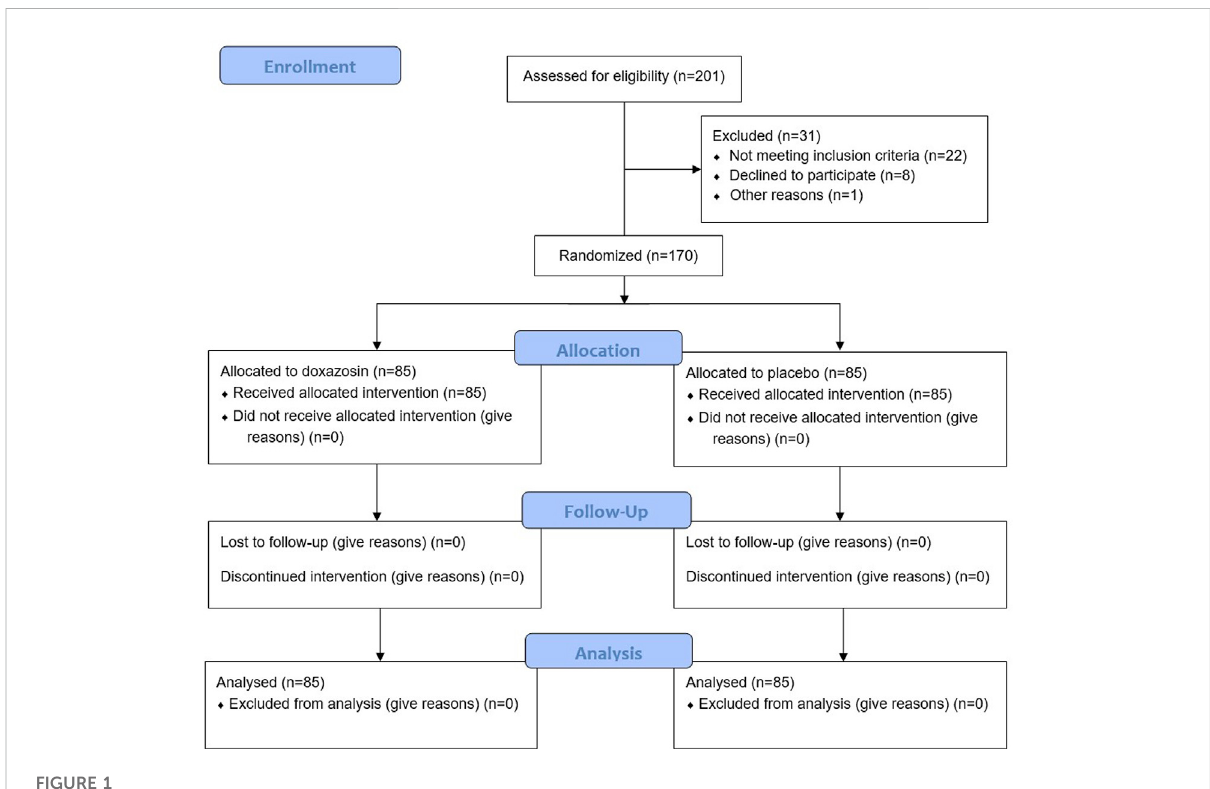
FIGURE 1 CONSORT fl ow